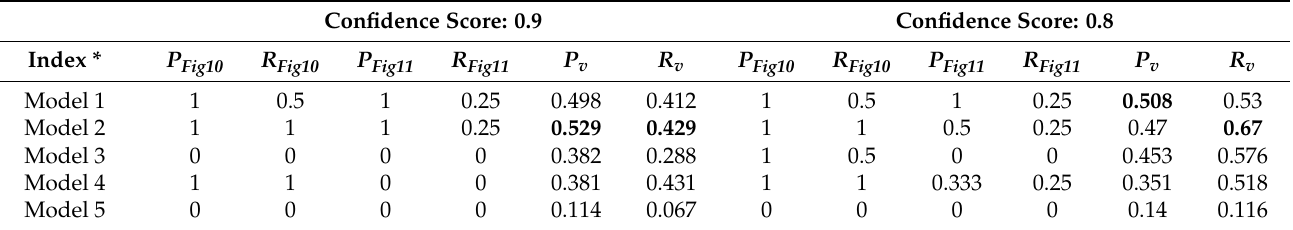
Table 8. Comparison of the experiment results between Figure 10, Figure 11, and validation set. Confidence Score: 0.9 Confidence Score: